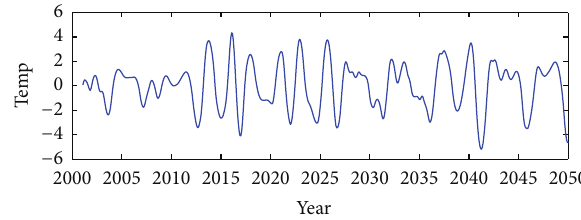
Figure 8: The bandpass filtered HYCOM-simulated SST in Nino3.4 region from 2001–2050.